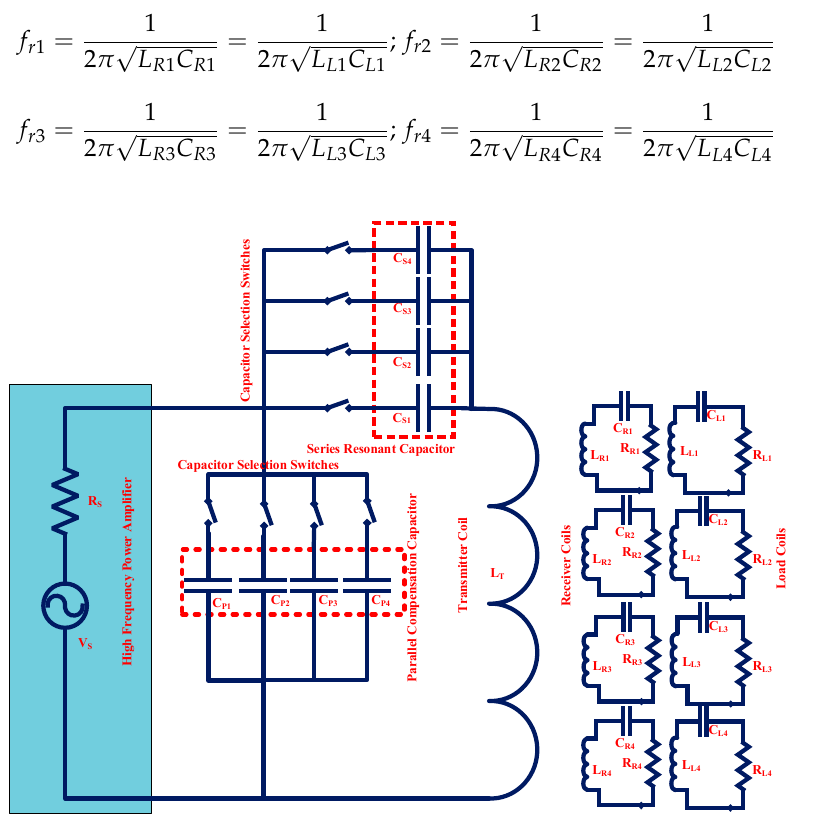
Figure 4. Equivalent circuit of Selective MRWPT system.